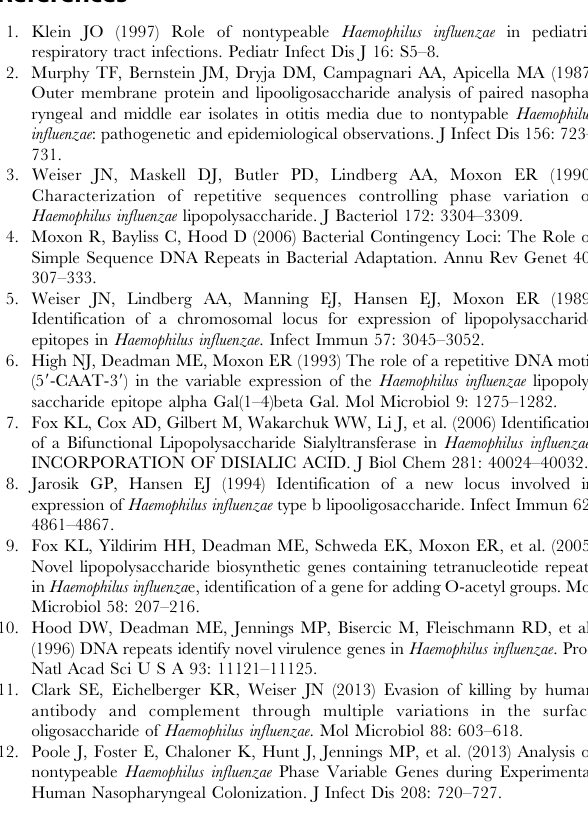
Table S1 NTHi strains used in this study. * strains